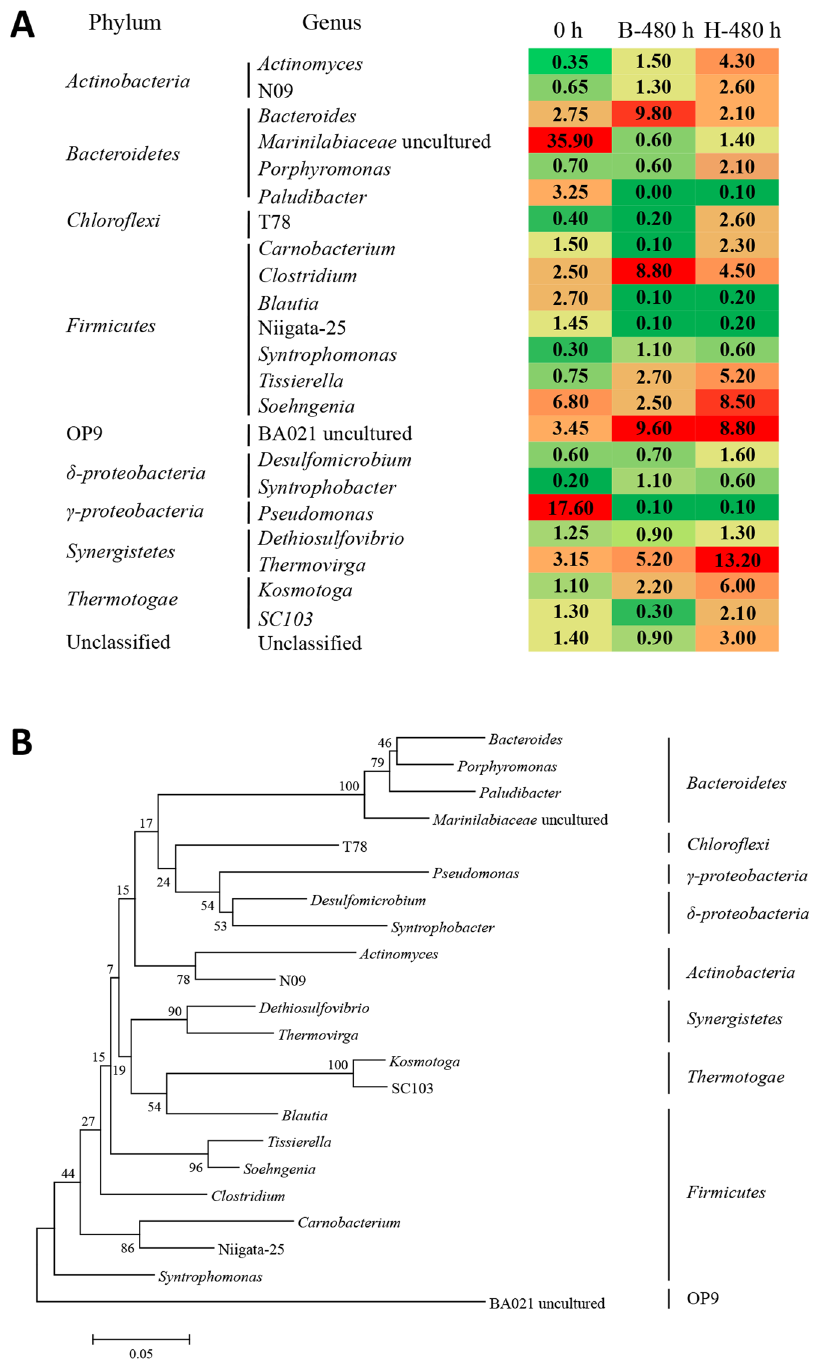
Figure 5. Percentages of the major genera ( A ) in each sample and neighbor-joining phylogenetic tree ( B ) of different genera. The major means sequence percentage is above 1% in any sample. 0 h stands for the samples that were collected immediately after inoculation. B-480 h and H-480 h stand for the samples at 480 h of the blank and H group respectively. A more red intense color corresponds with higher percentages, and deeper green colors indicate the lower percentages. For the phylogenetic tree construction, the neighbor-joining method was used and sequences were aligned using Clustal X 1.8 and MEGA 5.1. The bar represents 5% sequence